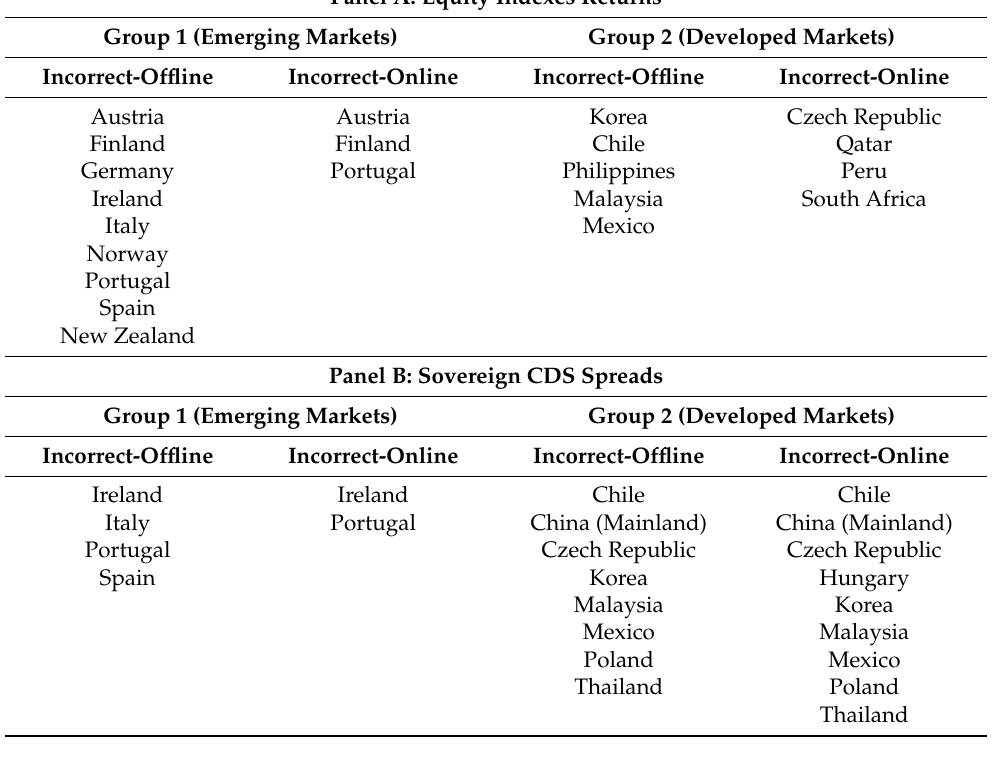
Table 3. The misclassification cases when using offline algorithm on offline dataset and online algorithm on online dataset. Panel A reports the mis-categorized economics entities in the stock index clustering case, and Panel B reports the mis-categorized economics entities in the sovereign CDS spreads clustering case. The algorithm clusters the dataset into two groups: emerging market group and developed market group. The mis-categorized outcome are reported, where (i) entities from developed markets incorrectly clusters in emerging market, or (ii) vice